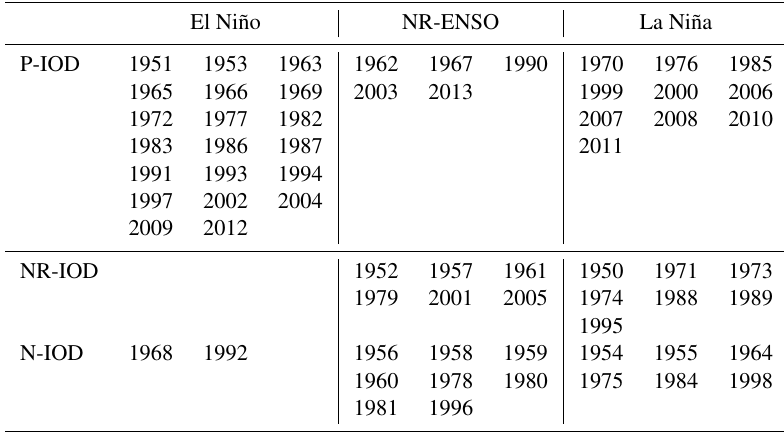
Table 5. ENSO, IOD, and neutral events during the 1950–2013 period.